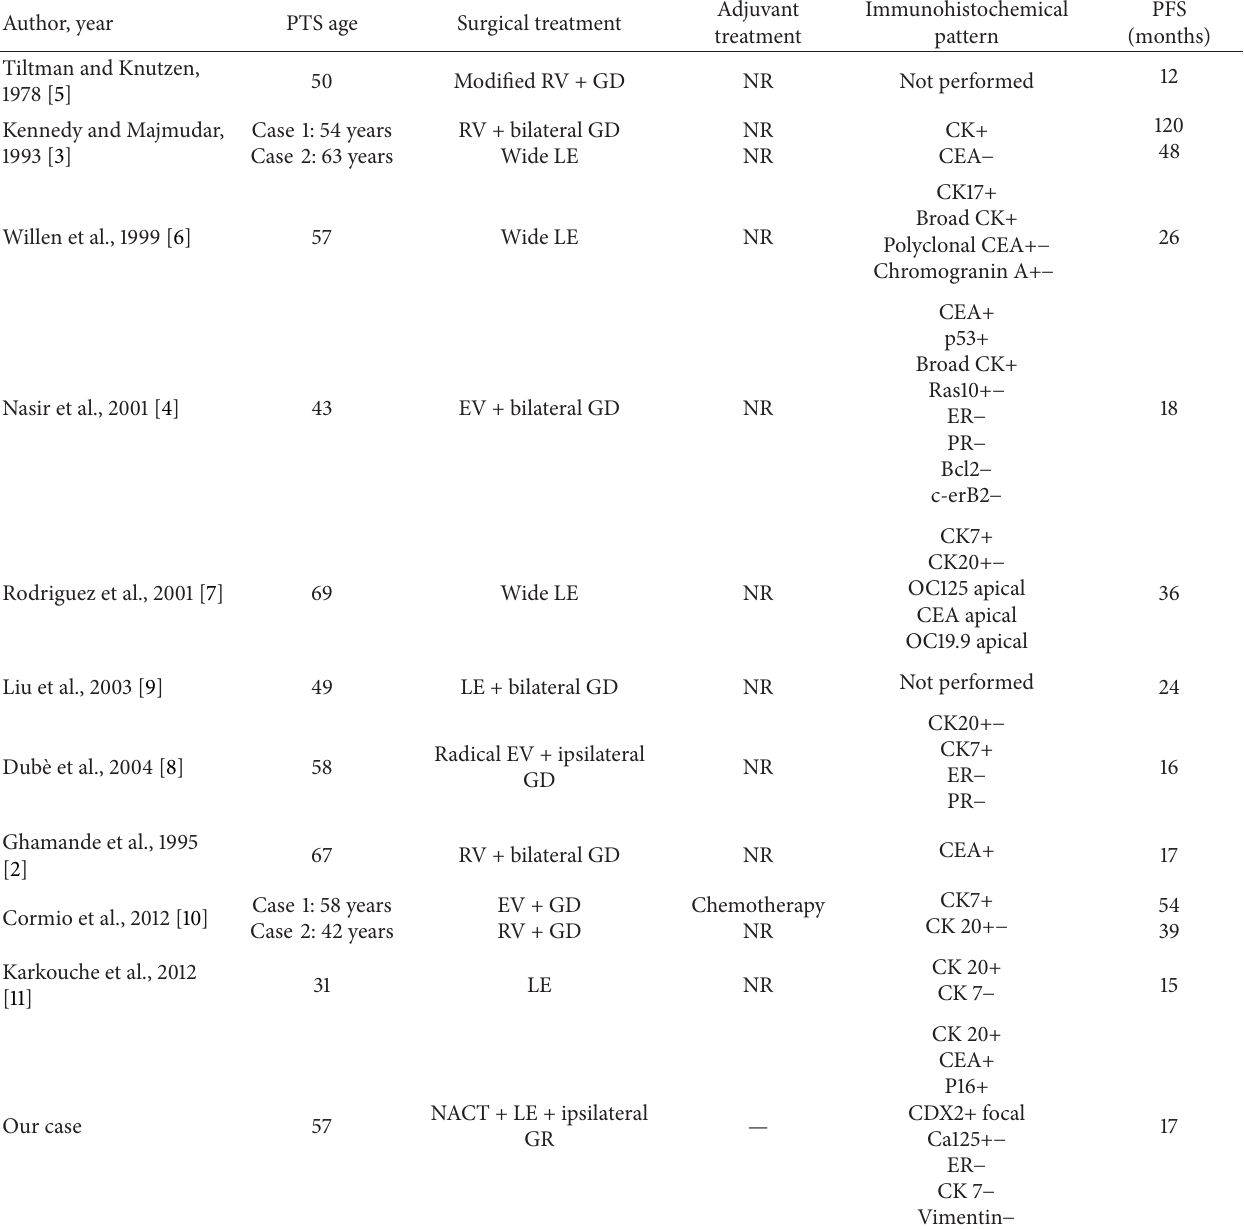
Table 1: The literature reported vulvar intestinal adenocarcinoma